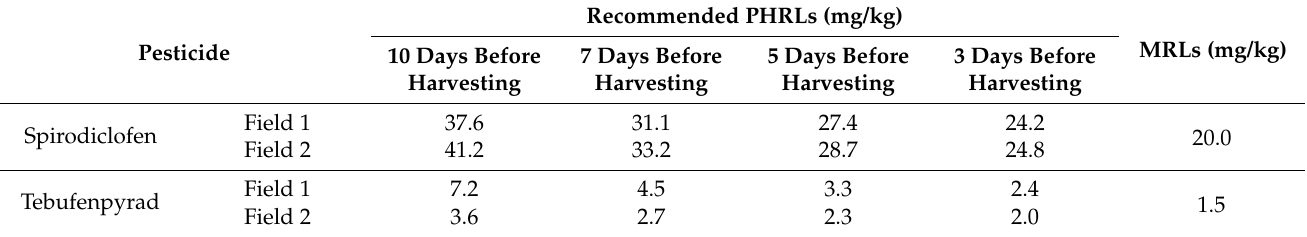
Table 4. Recommended pre-harvest residue limits (PHRLs) of spirodiclofen and tebufenpyrad in Aster scaber .